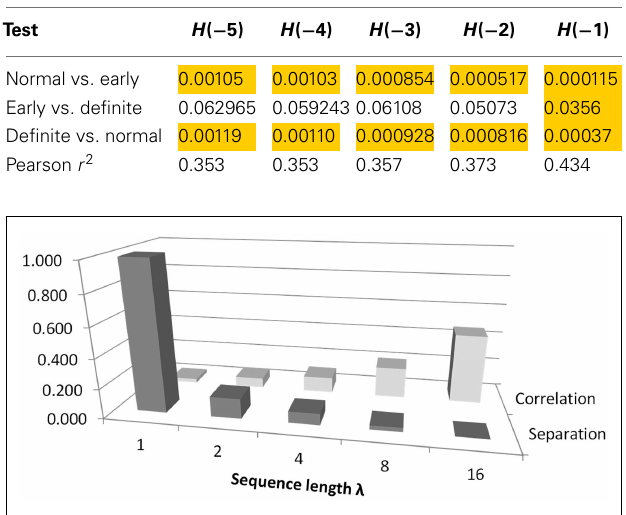
Table 5 | Results of Mann–Whitney tests for Renyi entropy calculated with negative exponents and using method 8 .